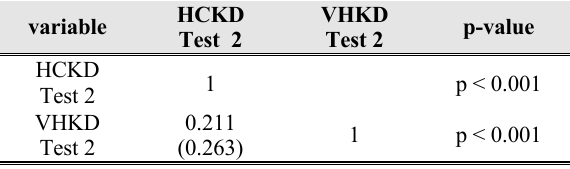
Correlation between HCKD and VHKD (Test 2) variable